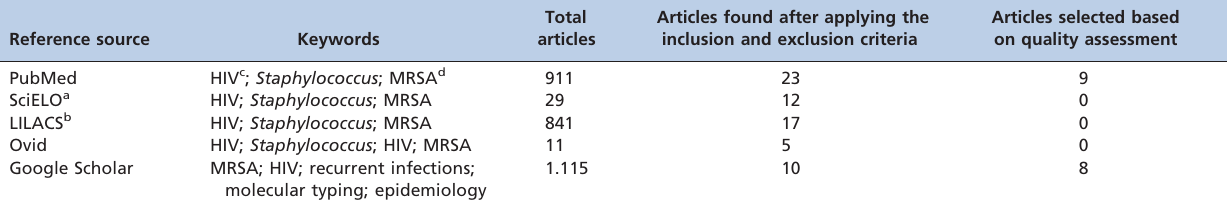
Table 2 - Databases and search